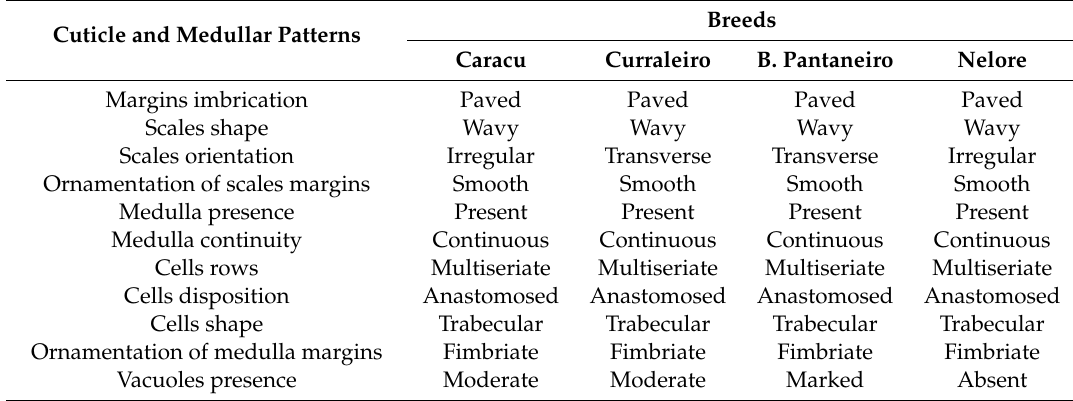
Table 1. Synopsis of morphological patterns used in the identification and di ff erentiation of the bovine breeds studied.